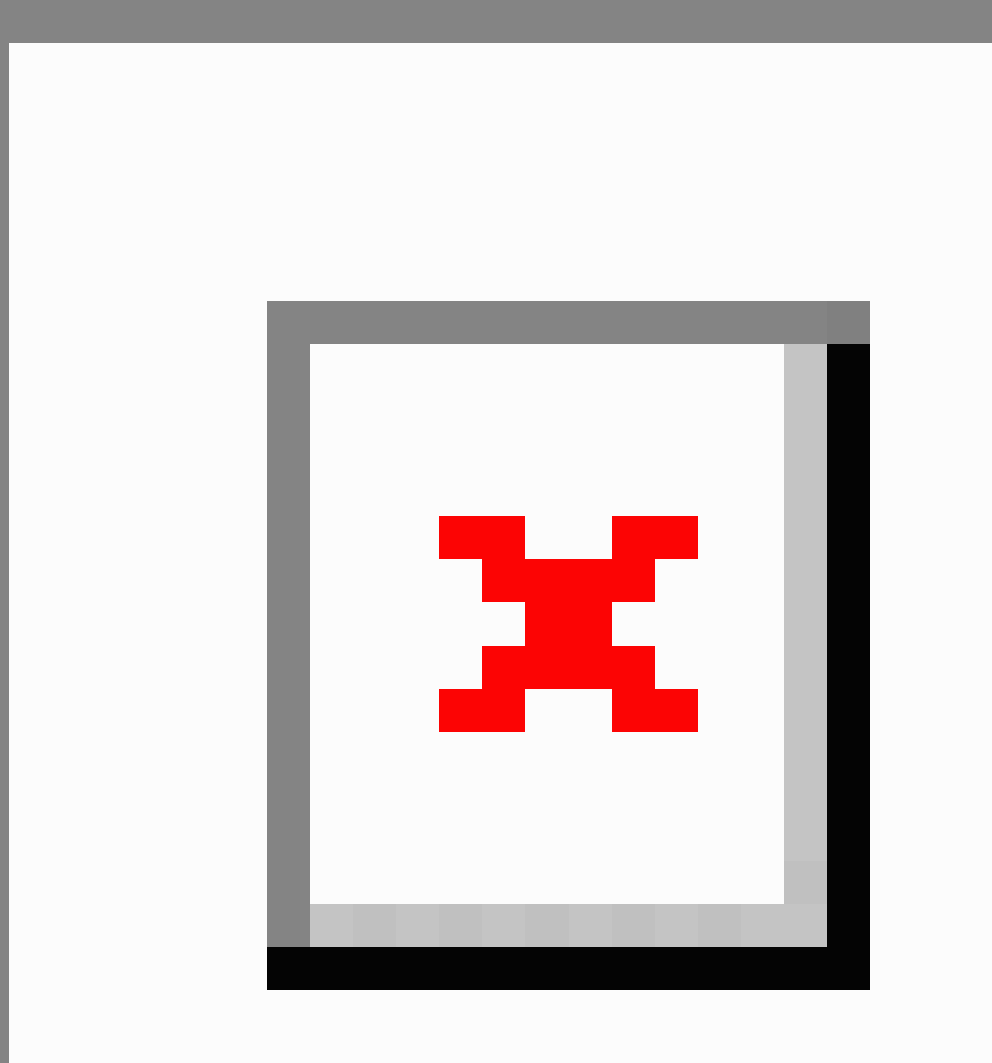
Figure 1. The multiple stages through which studies were selected for inclusion using the PRISMA flow